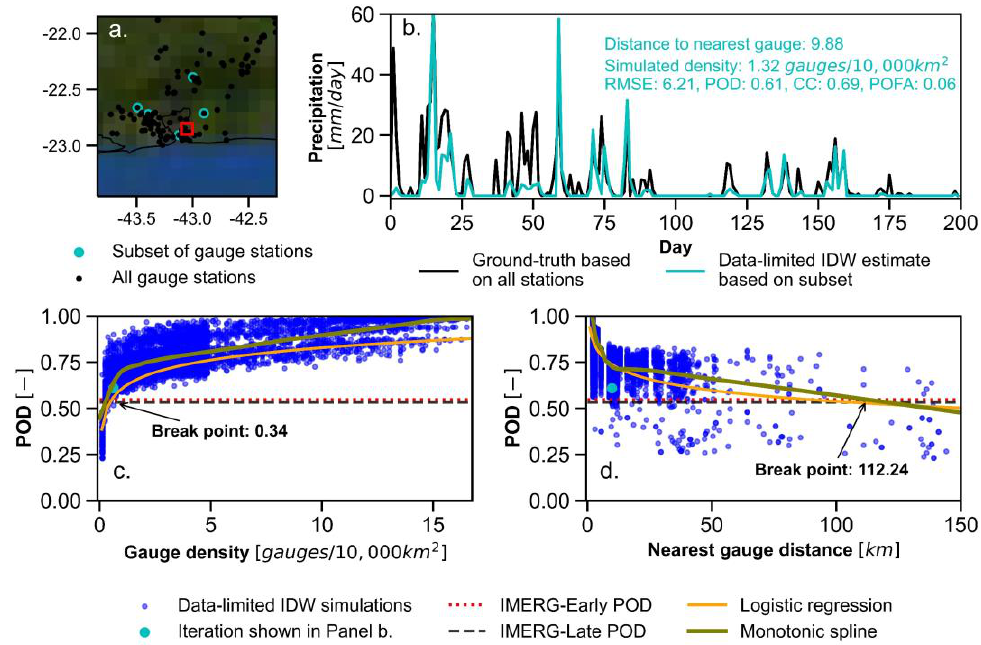
Figure 2. Monte Carlo “data-limited” interpolation scheme implemented for a 0.1 ◦ pixel in Rio de Janeiro (red). ( a ) All available gauges (black) used to calculate ground truth precipitation for a pixel at ( − 43.05, − 22.85) and randomly selected subset of gauges (light blue) used in one iteration of the Monte Carlo Scheme. ( b ) Timeseries of ground truth precipitation and data-limited interpolation using subset of gauges shown in ( a ). Performance metrics for the data-limited interpolation are displayed in light blue. ( c ) Probability of Detection (POD) calculated for all iterations of the Monte Carlo Scheme plotted as a function of simulated gauge density and logistic regression (orange) and monotonic spline (olive) fit to POD data. The POD of IMERG-Early and IMERG-Late are shown in comparison (dashed black and red lines). ( d ) POD from Monte Carlo Scheme results as in (b) but plotted and fit with regressions as a function of simulated distance to nearest